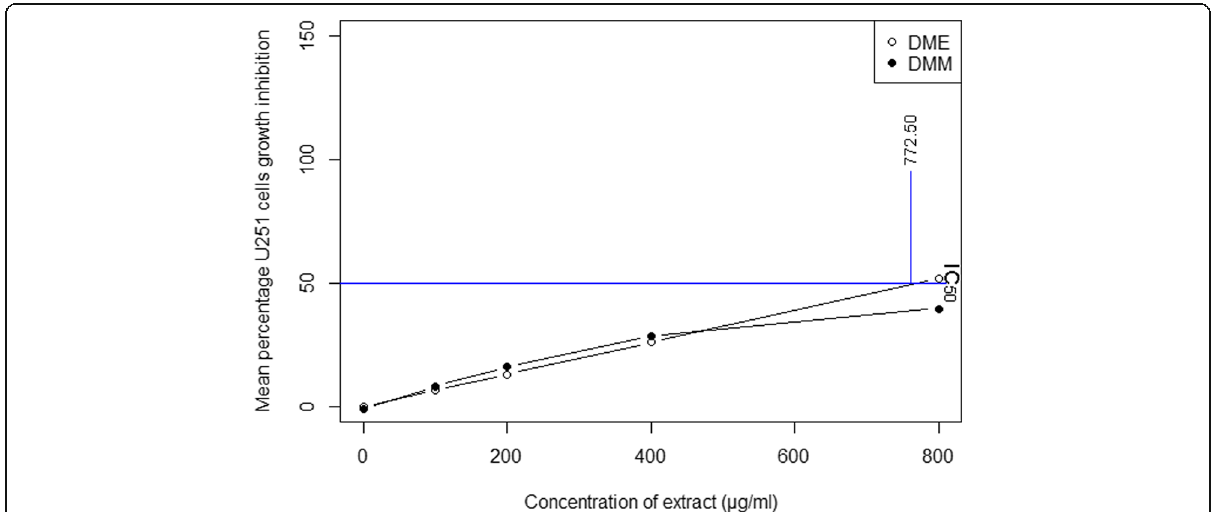
Fig. 4 Percentage of cell growth inhibition of the U251 cell line by crude extracts of D. moniliforme and their cytotoxic capacities ( n = 3; p ≤ 0.05)